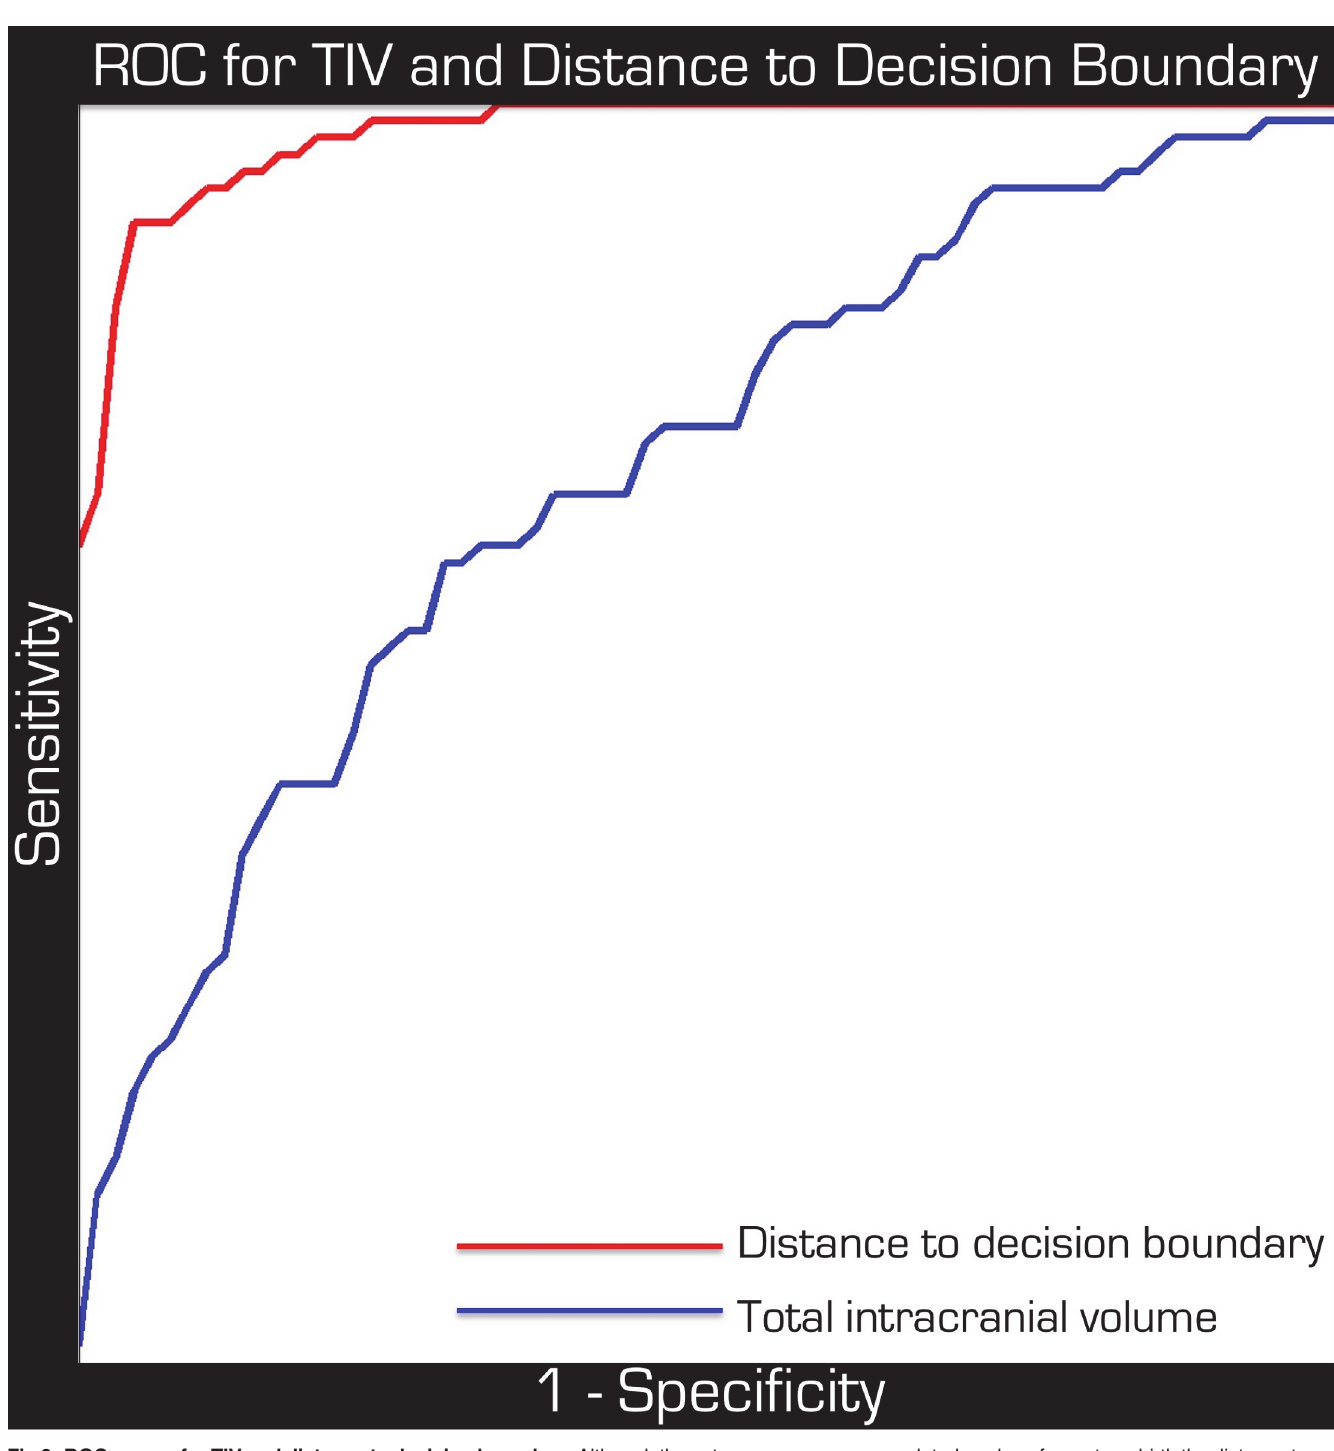
Fig 3. ROC curves for TIV and distance to decision boundary. Although these two measures are correlated markers for preterm birth the distance to decision boundary (red curve) is statistically significantly better. Both the x and y axes run between 0 and 1.